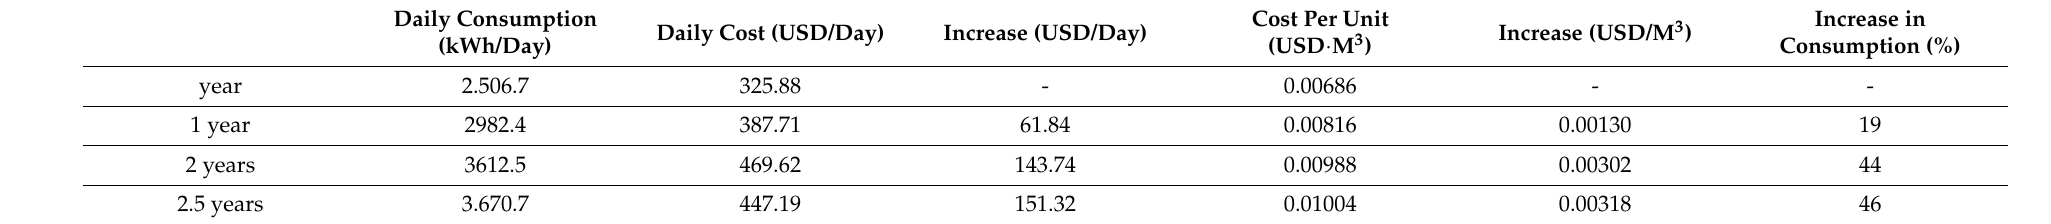
Table 7. Summary of the impact of GM bioinfestation at Rio Branco EPS until the period of